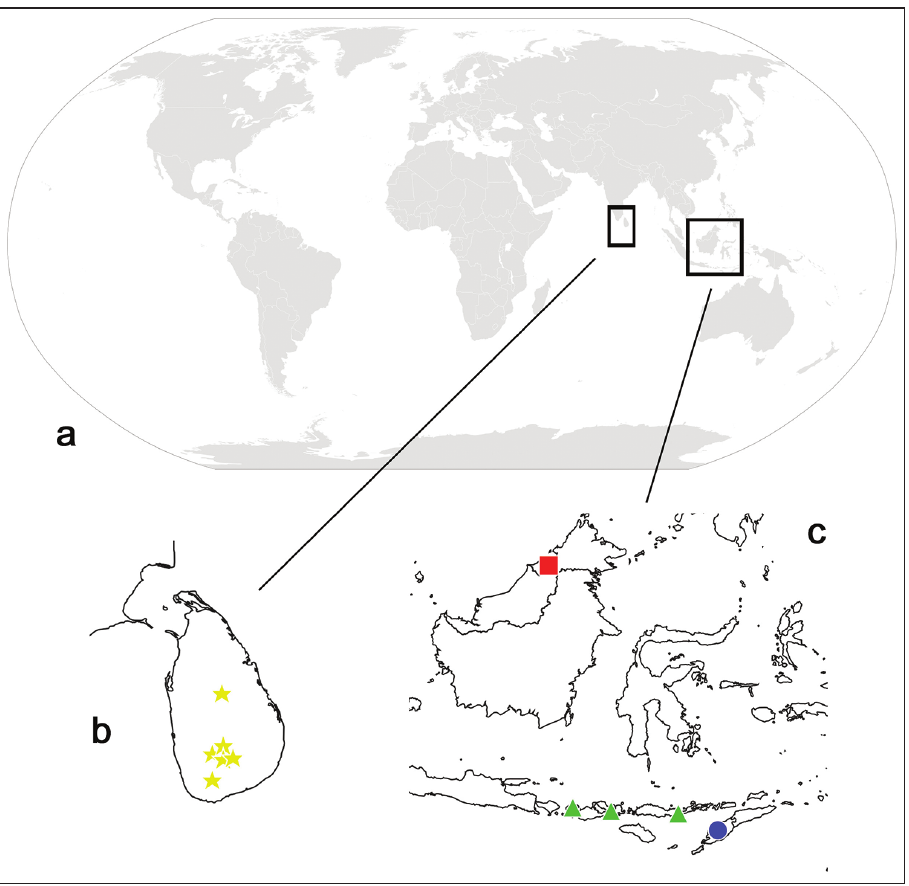
Figure 7. Distribution of Indocloeon : a World map (http://www.pixabay.com) b Sri Lanka c Indonesia (partim) and Brunei (yellow stars, I. primum ; red square, I. spathasetis sp. n.; green triangles, I. indonesiae (from left to right: islands of Lombok, Sumbawa, Flores); blue spot, I. timorense sp. n. (island Timor)).